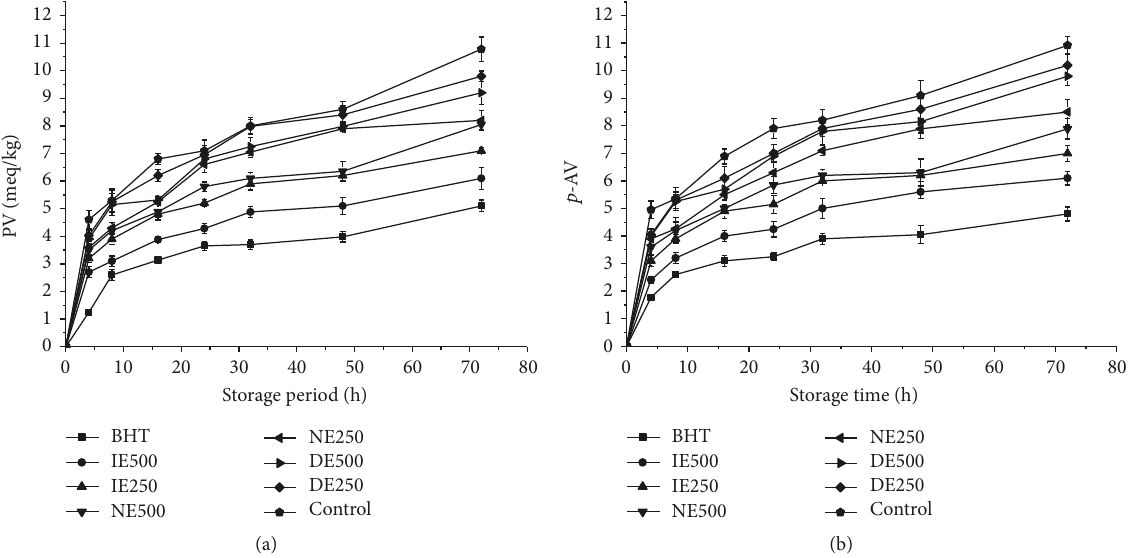
Figure 3: The changes of PV (a) and 𝑝 -AV (b) during different storage time (h) (BHT, butylated hydroxytoluene; IE, isopropanol extract; NE, normal hexane extract; DE, diethyl ether